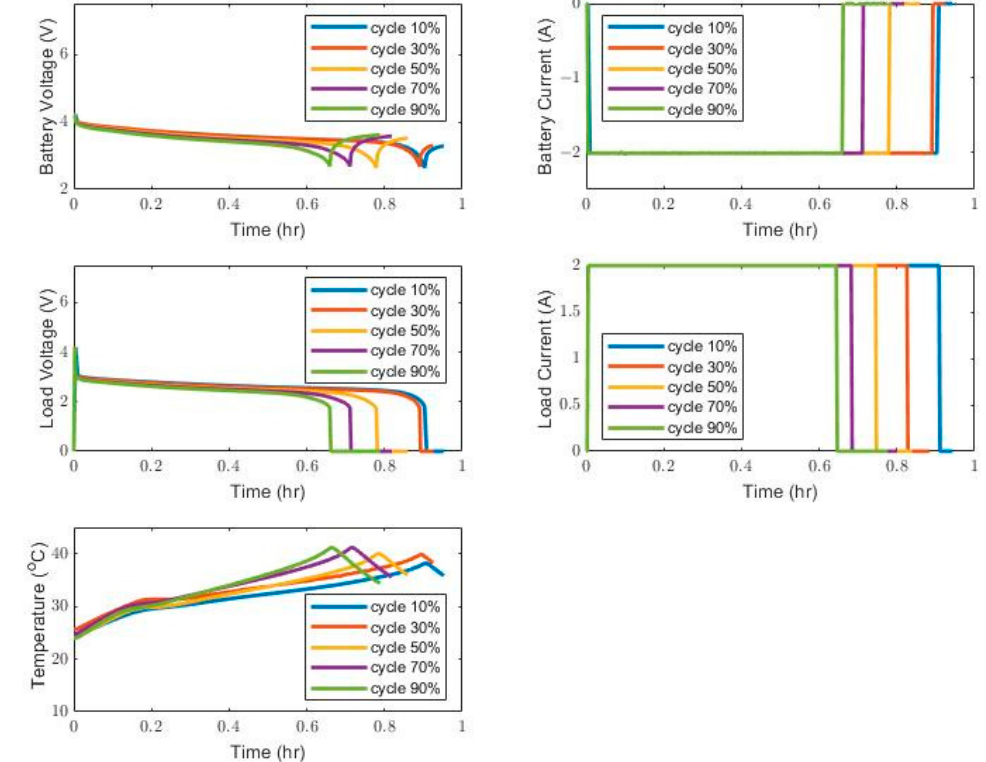
Figure 5. Feature variations in the charging stage related to cycles.